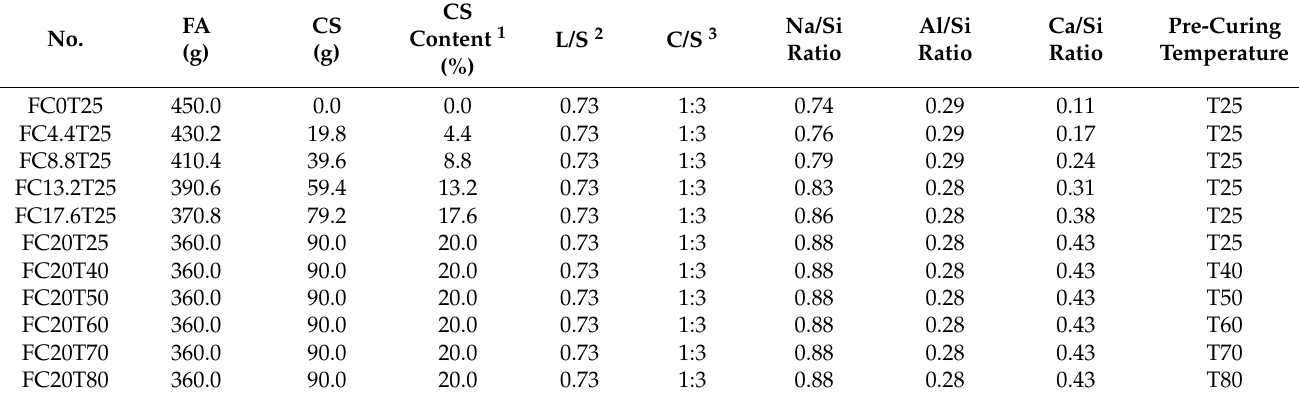
Table 3. Mixing proportions and pre-curing temperatures of CS–FA–GEO composite samples.